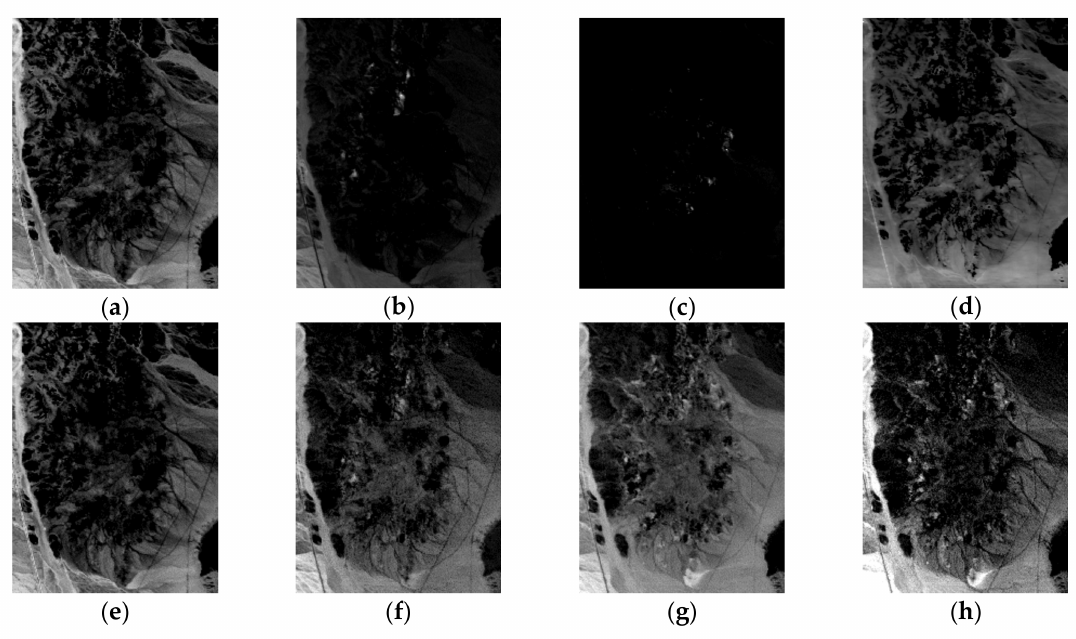
Figure 14. Muscovite: ( a ) VCA, ( b ) N-FINDR, ( c ) SGA, ( d ) C-NMF, ( e ) MVC-NMF, ( f ) ICE, ( g ) SPICE, ( h )